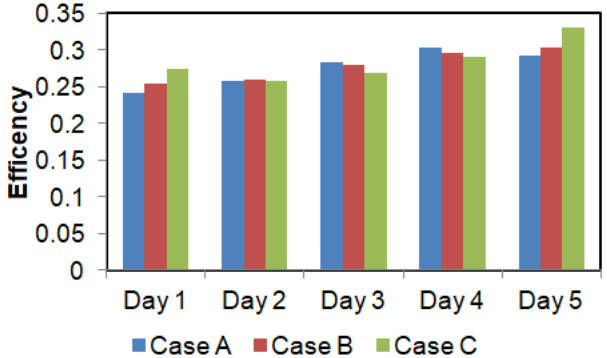
Figure 8. Relationship between efficiency and observation time for five days.